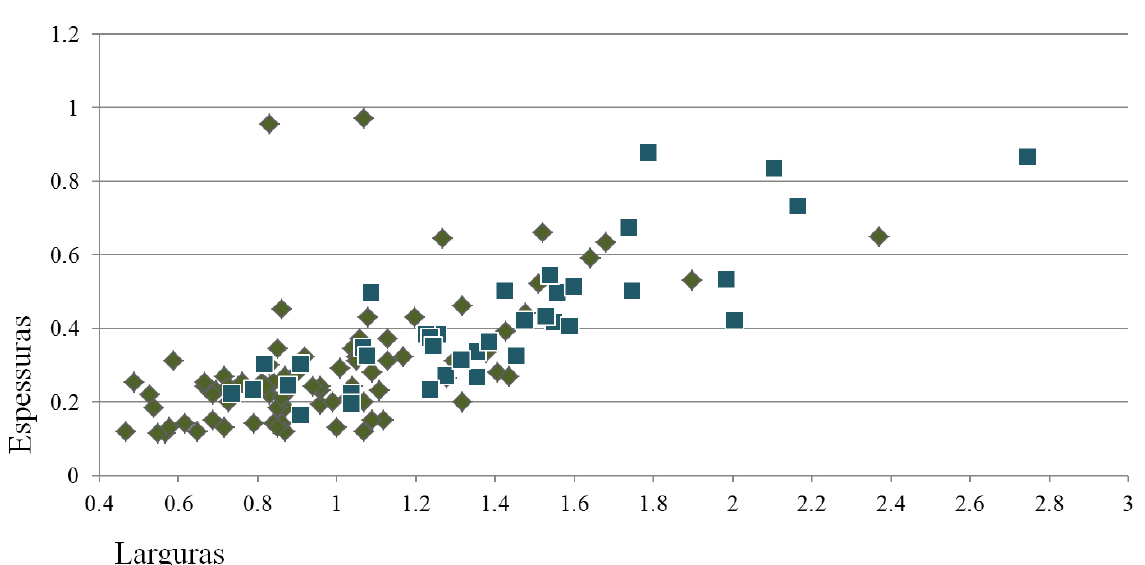
Figura 9. Variação da dispersão das larguras e espessuras (em cm) dos produtos alongados (em bruto, retocados e com sinais de uso) em sílex dos sítios de habitat do Meu Jardim (losangos verdes) e Cerradinho do Ginete (quadrados azuis). Figure 9. Plotting of widths and thicknesses (in cm) of blades or bladelets (unretouched, retouched and with use wear) in flint from the habitation sites of Meu Jardim (green diamonds) and Cerradinho do Ginete (blue